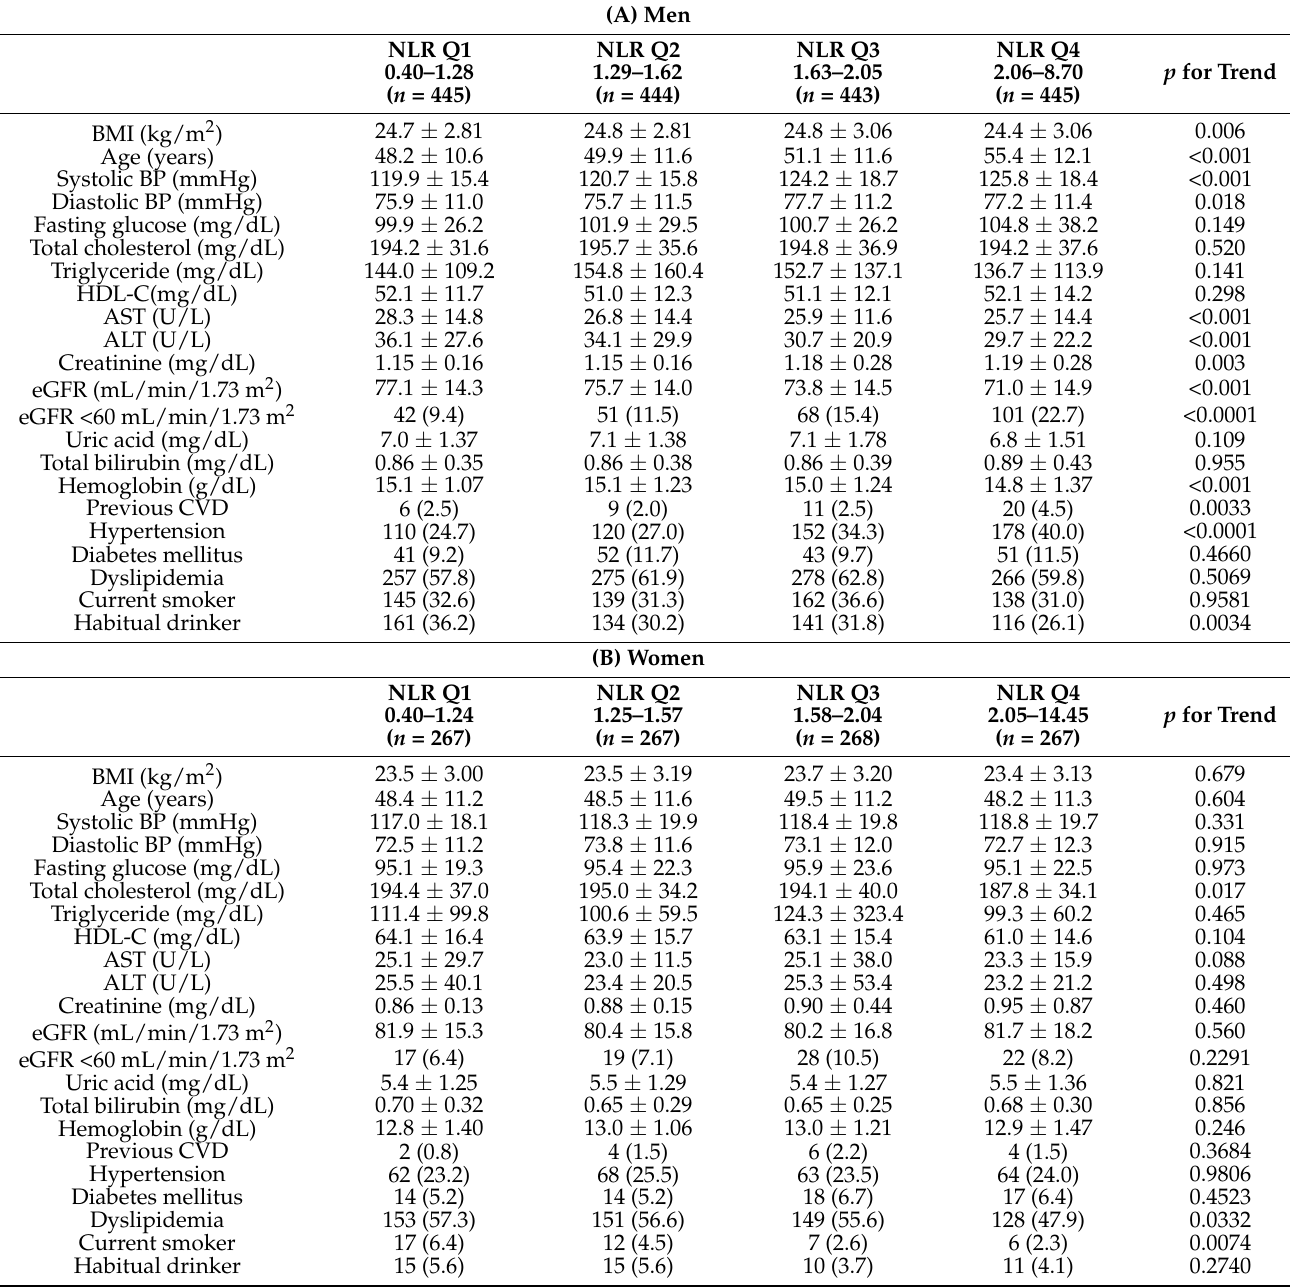
Table 2. Characteristics Represented across Quartiles of NLR in Men ( A ) and Women ( B